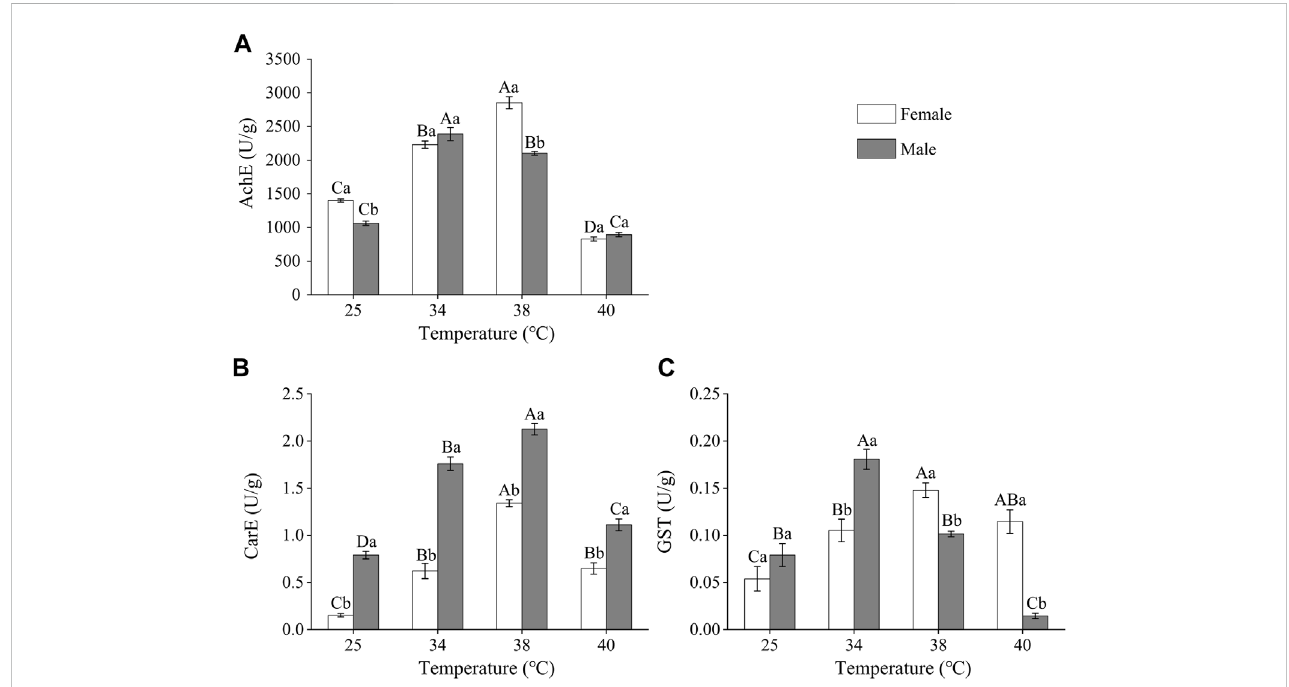
FIGURE 3 The activities of detoxifying enzymes in Z. tau adults exposed to different high-temperature treatments for 12 h. Data are presented as the mean ± SE. Different lowercase letters above bars represent a signi fi cant difference in the detoxifying enzyme activity between females and males at the same temperature, while different uppercase letters above bars indicate a signi fi cant difference in the detoxifying enzyme activities of females/males at different temperatures ( p < 0.05) (A) AchE (B) CarE, and (C)